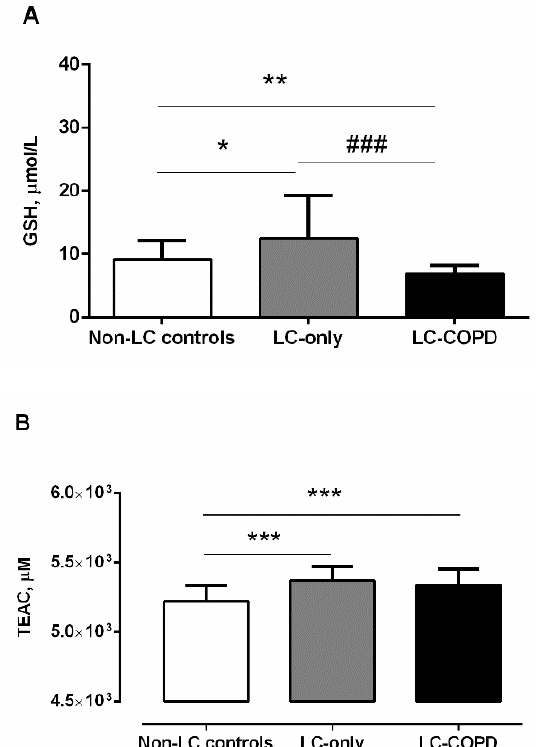
Figure 4. ( A ) Mean values and standard deviation of plasma GSH levels ( µ mol/L) were significantly higher in LC-only patients than in non-LC patients. However, levels of GSH in LC-COPD patients were significantly lower than in both non-LC controls and LC-only patients. Statistical significance: * p < 0.05, ** p < 0.01 between either of the two groups of patients with LC and the non-LC control subjects, and ### p < 0.001 between LC-COPD and LC-only patients. ( B ) Mean values and standard deviation of plasma TEAC (µM) were significantly higher in both LC-COPD and LC-only patients compared to non-LC controls. Statistical significance is as follows: *** p < 0.001 between any group of LC patients and the non-LC controls. The absence of statistical symbols indicates that no significant differences were found between groups for the different study comparisons.